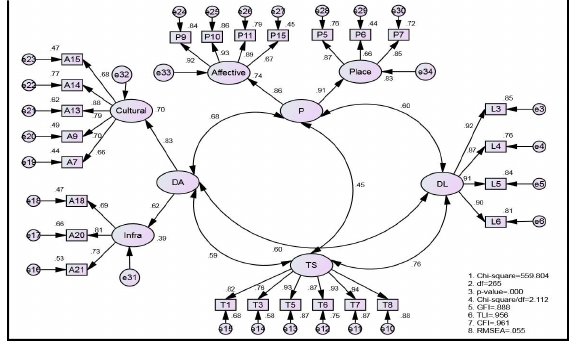
Fig. 2. The Final Pooled Measurement Model